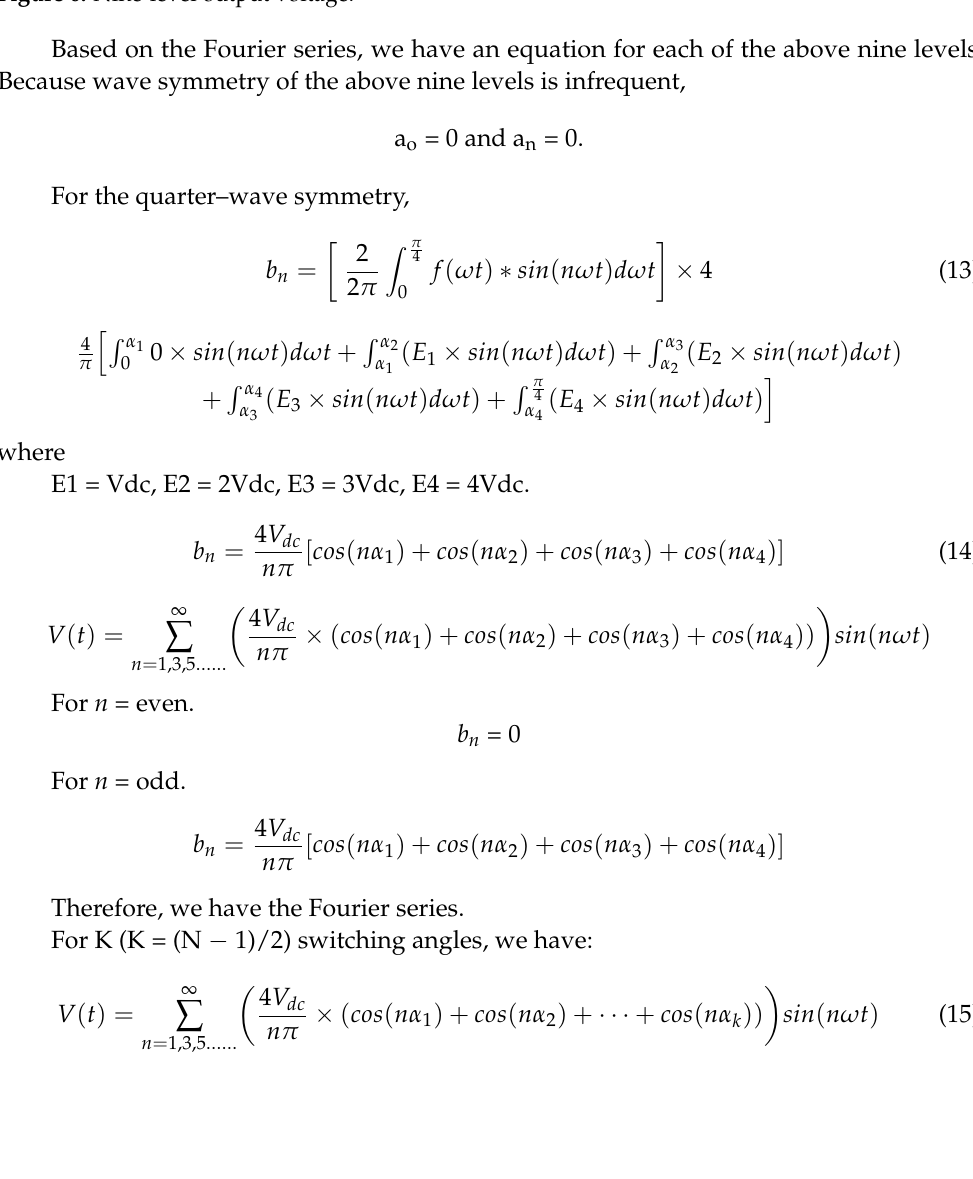
Figure 6. Nine - level output voltage. Figure 6. Nine-level output